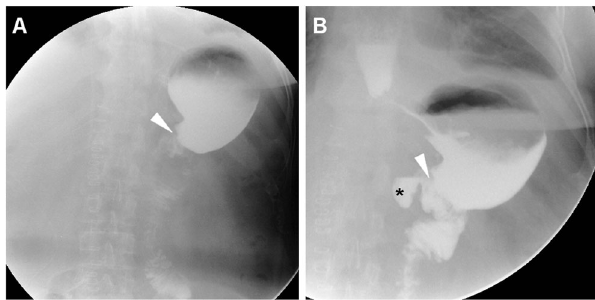
Fig. 4 In a 62-year-old male, CF performed five days after uncomplicated partial gastrectomy showed opacified, moderately dilated remnant stomach, slow transit of iodinated contrast through the GJS (arrowheads) and opacified Roux-en-Yanastomotic recess (*)